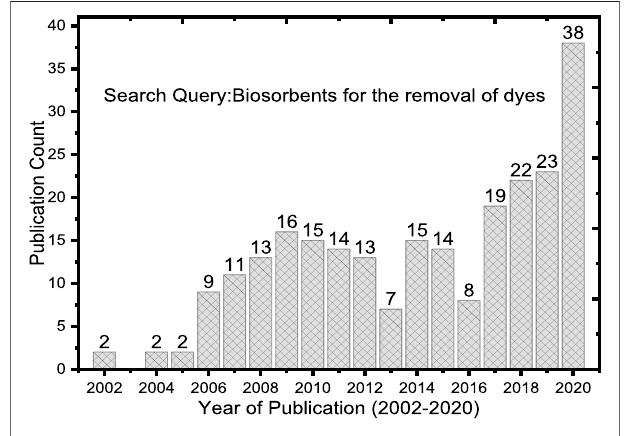
FIGURE 1 | Publication trends from the years 2002 – 2020 in the Biosorbents application for the removal of dyes.